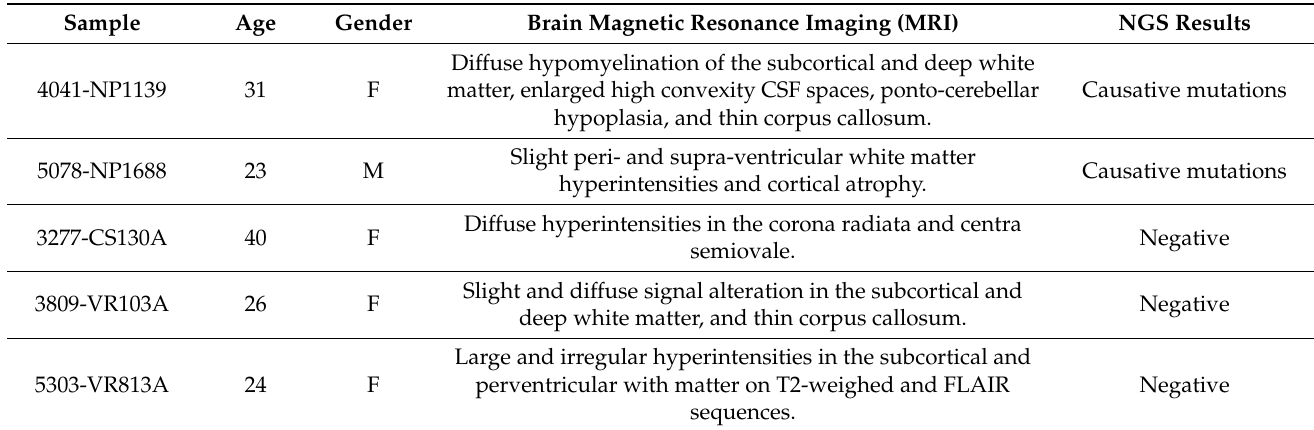
Table 1. Patients with leukodystrophy analyzed with in-house NGS genes